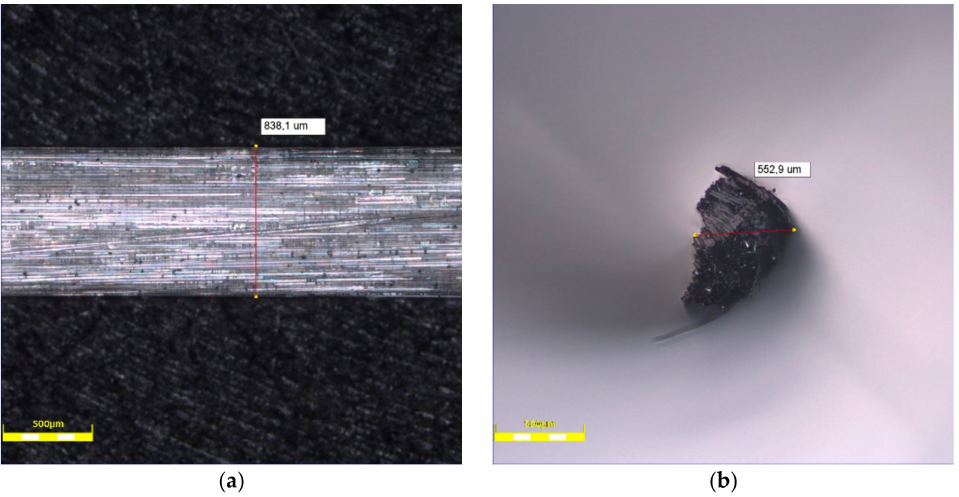
Figure 5. Optical microscope images of glass fiber: ( a ) surface, ( b )